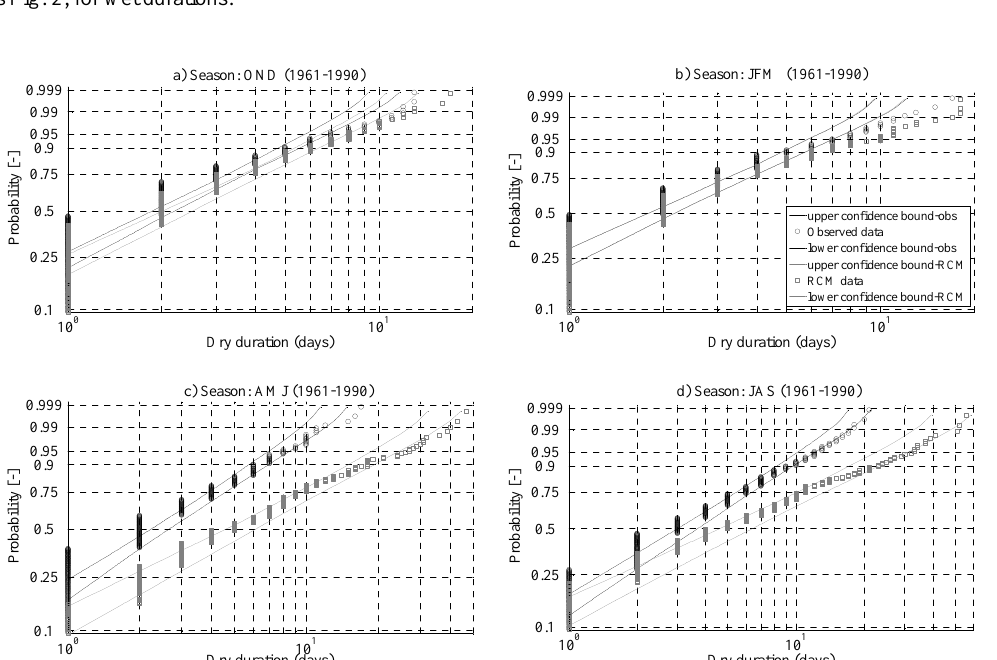
Fig. 3. Same as Fig. 2, for wet durations.